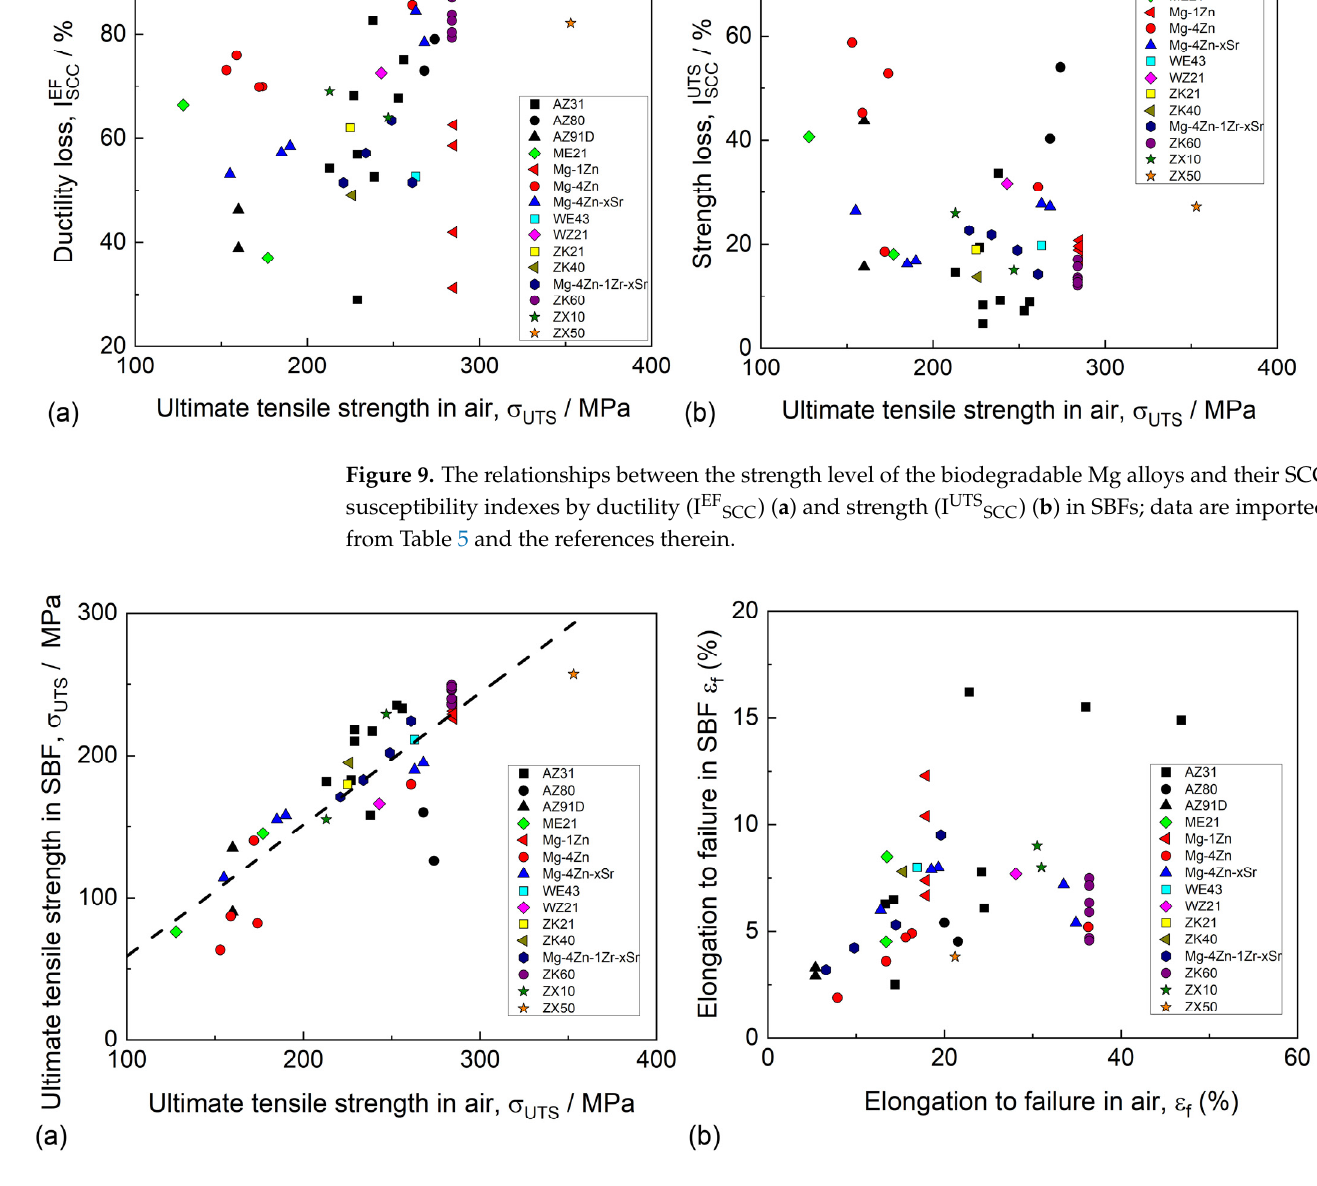
Figure 10. The relationships between the strength ( a ) and ductility ( b ) of the biodegradable Mg alloys in air and in SBFs; data are borrowed from Table 5 and the references therein.